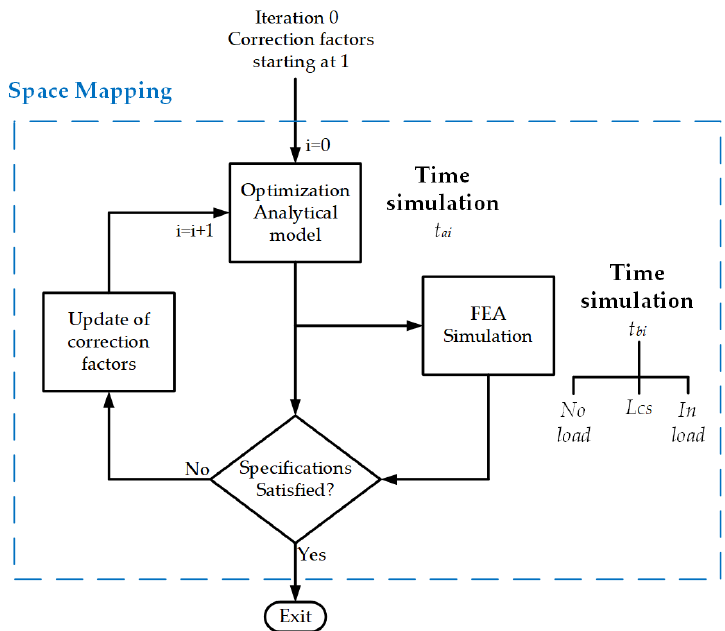
Figure 5. Space mapping technique execution diagram.